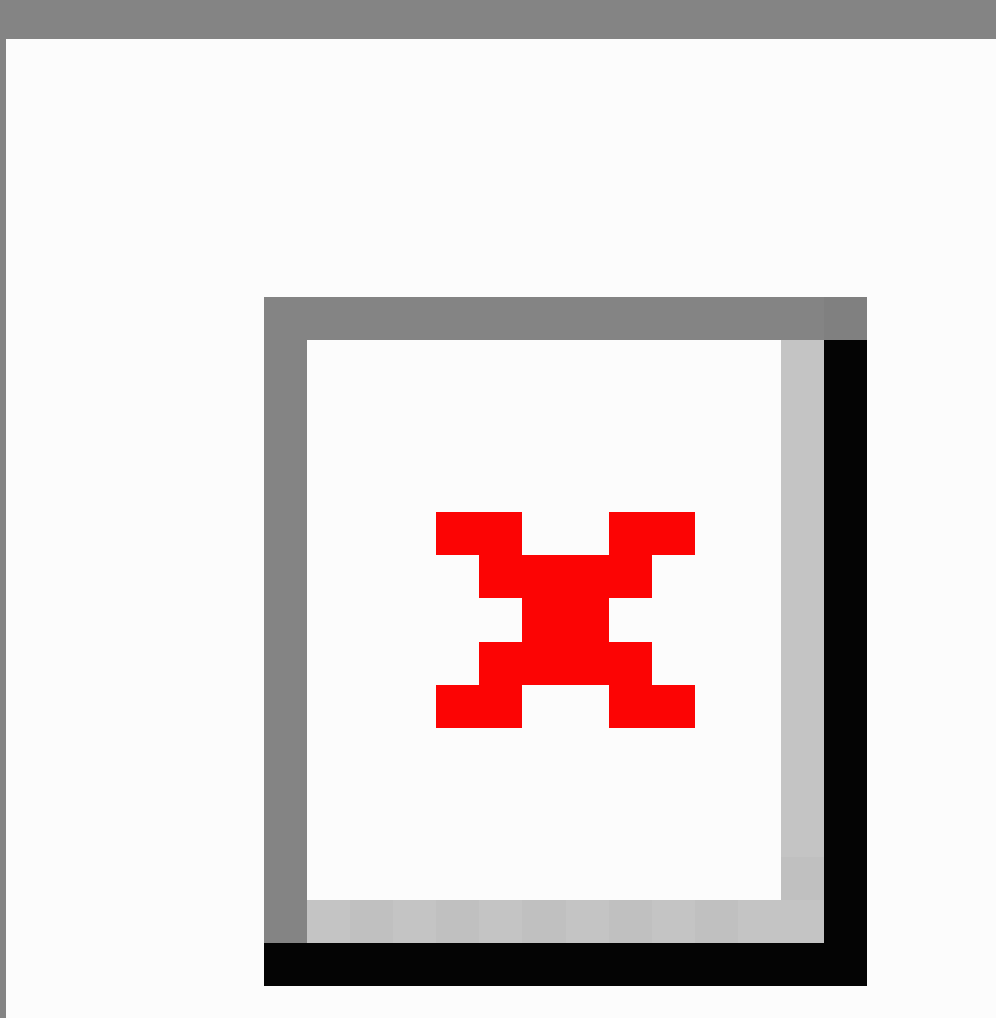
Figure 6. Mean change from baseline in Patient Activation Measure-13. Data are presented as least squares means and standard